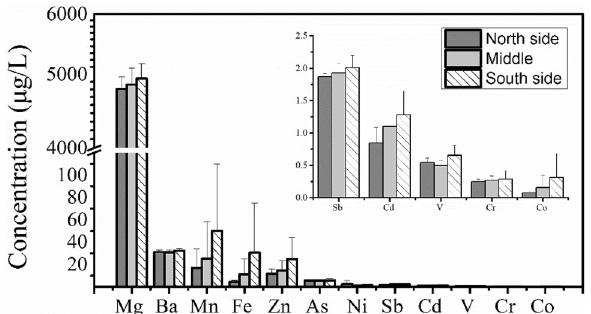
Figure 3. Metal concentrations in water samples collected at the south side, the north side, and in the middle of the river.